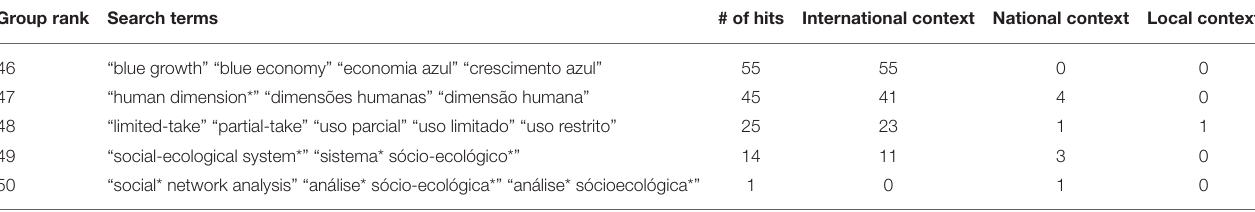
TABLE 5 | Percentage of documents that contain each group of search terms, according to the lexical analysis for the three spatial contexts for the bottom 5 search terms regarding the number of hits (appearances) for the each group of search terms, considering all contexts together. Group rank Search